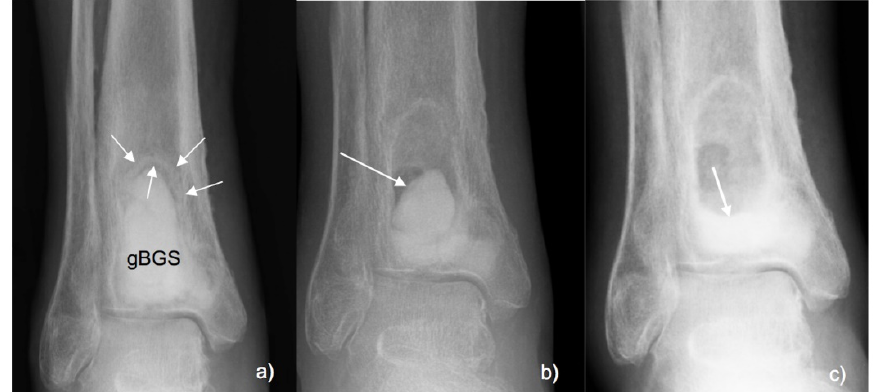
Figure 3. (A) AP radiograph 6 weeks after debridement and filling of an osteomyelitic bone void in the distal tibia. Halo sign: Radio-dense ring around the gBGS (arrows). (B) Marble sign noted at 12 weeks with remnant of the biocomposite appears in the bone void (arrow). (C) Puddle sign at 26 weeks with remnants of the biocomposite accumulating at the bottom of bone void (arrow).